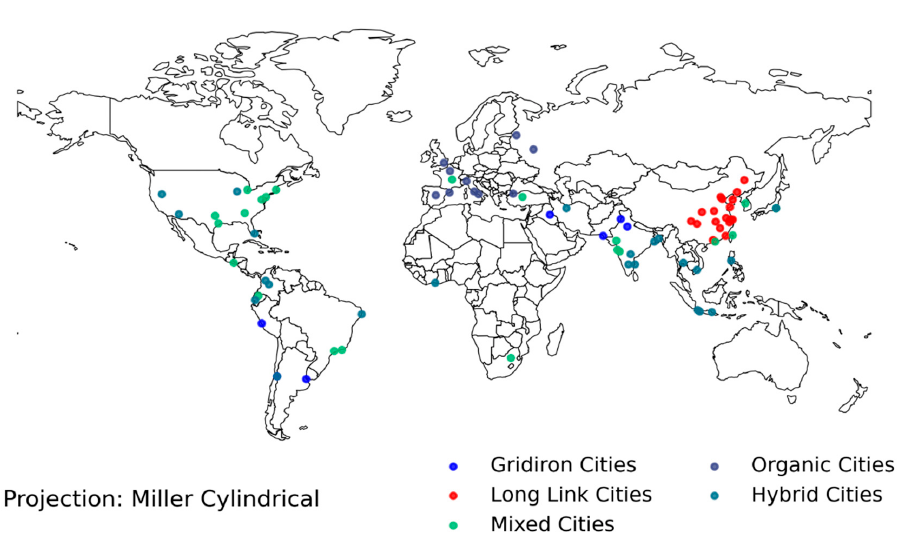
Figure 1. Different classes of cities projected onto a world map. Figure 5. Different classes of cities projected onto a world